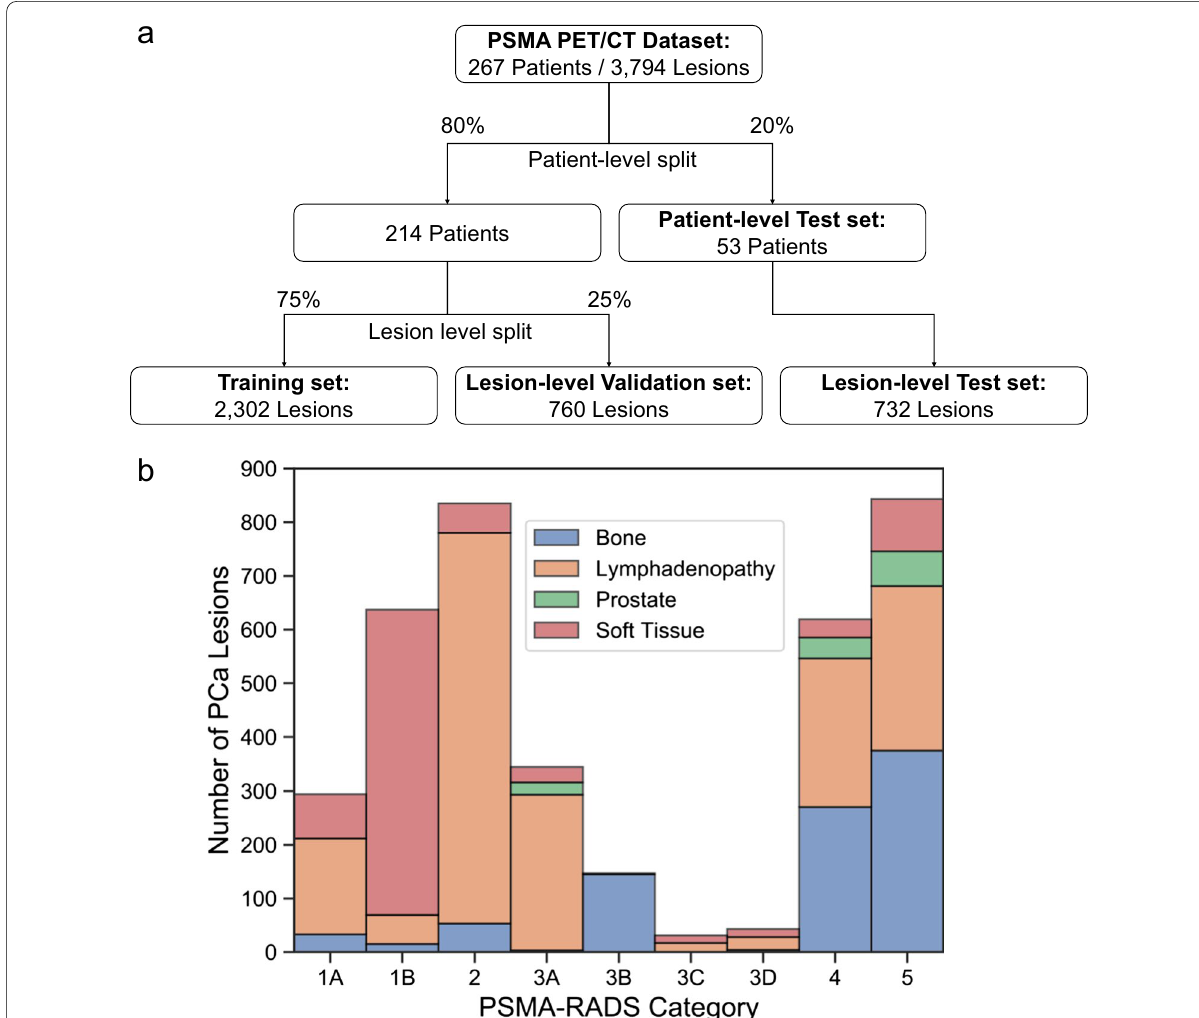
Fig. 1 Flowchart of data partitioning ( a ) and a histogram of dataset characteristics ( b ), including the distribution of PSMA-RADS categories and tissue type